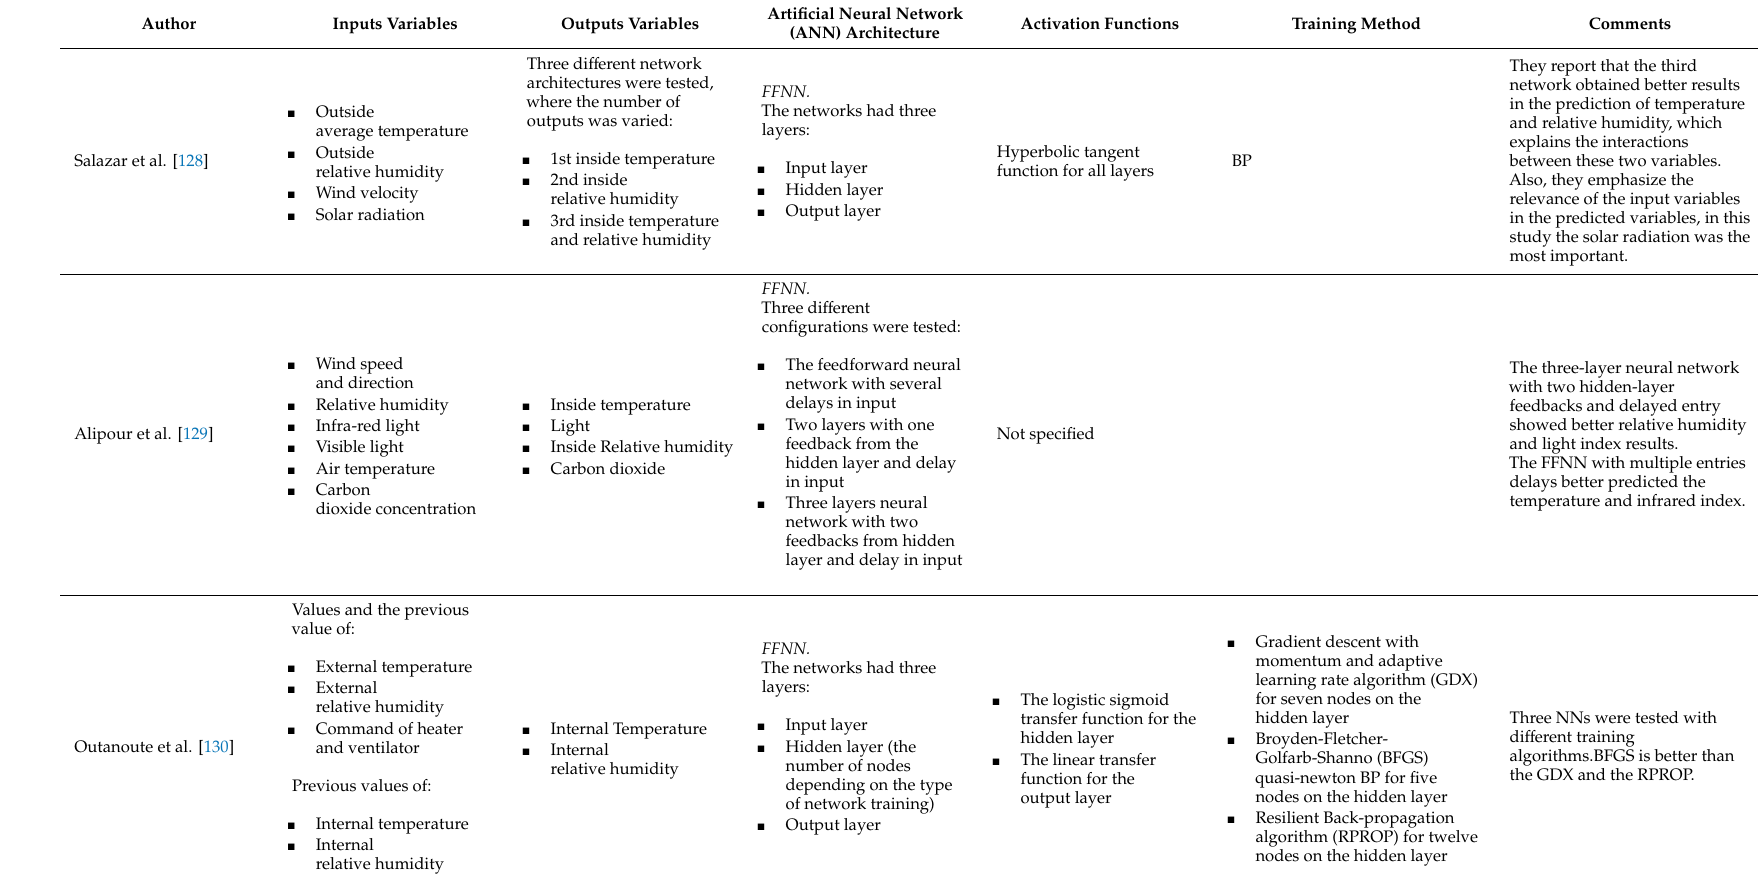
FFNN. The networks had three layers: